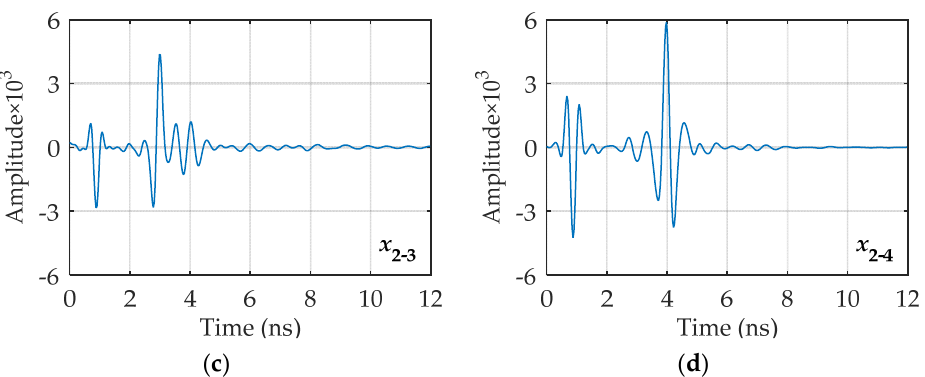
: ( a ) x 2 2 1 − : ( a ) x represents the signal of the 10 cm model box; 2 2 1 − 2 2 − represents the signal of the 10 cm model box; represents the signal of the 20 cm 2 2 − 2 4 − represents the signal of the 20 cm 2 4 −